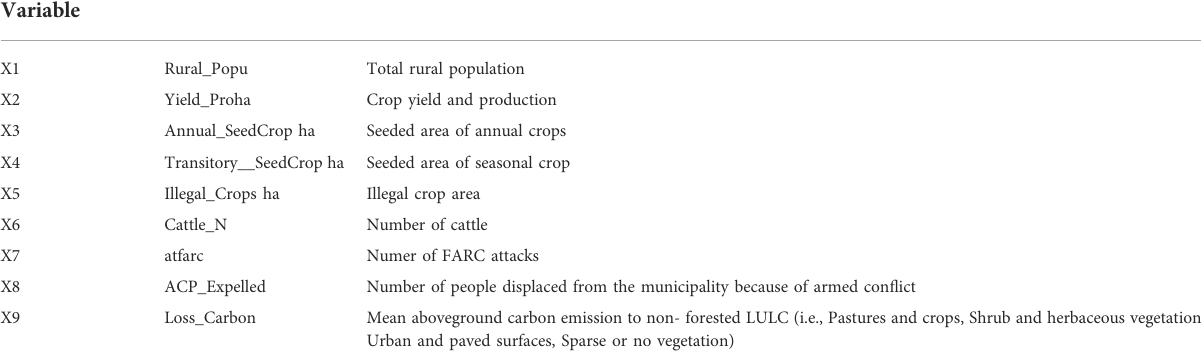
TABLE 8 Explanatory variables included in Model